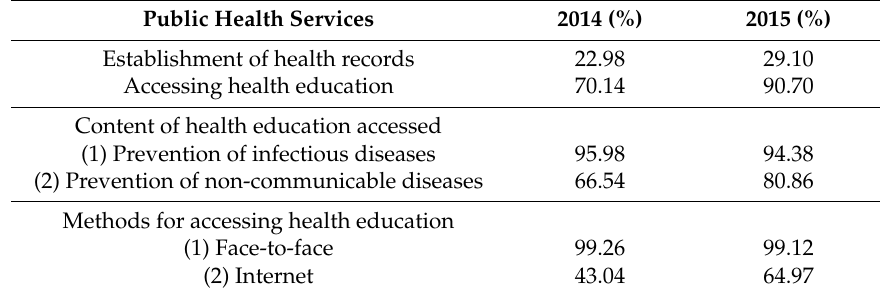
Table 2. Utilization of local public health services among internal migrants in NIMDMS, 2014 and 2015.